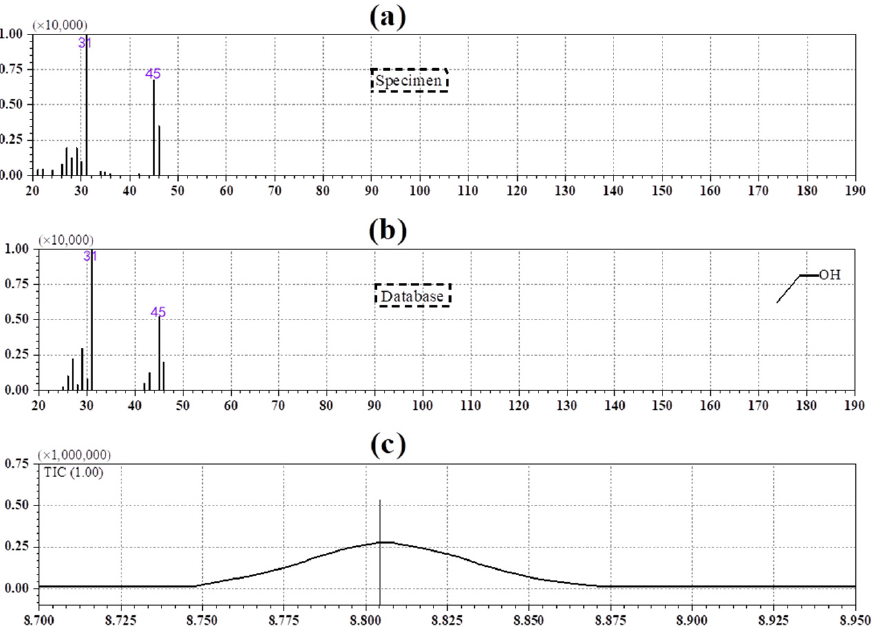
Figure 6. HS-GC-MS analysis of ethanol in the oil-impregnated insulating paper: ( a ) a sample of Figure 6. HS ‐ GC ‐ MS analysis of ethanol in the oil ‐ impregnated insulating paper: ( a ) a sample of aged fragments; ( b ) the NIST database; ( c ) the production time of ethanol. aged fragments; ( b ) the NIST database; ( c ) the production time of ethanol.